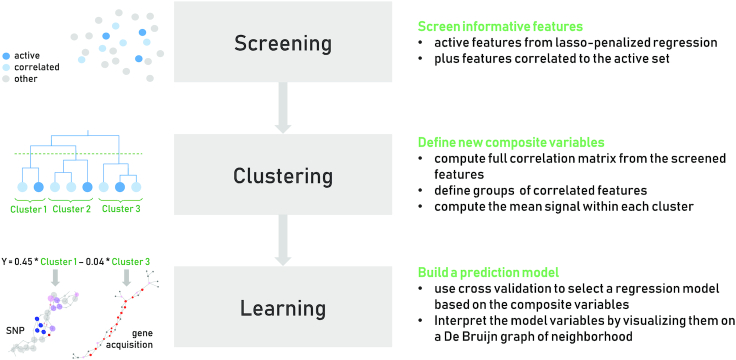
Three-step process. Illustration of the proposed 3-step procedure.